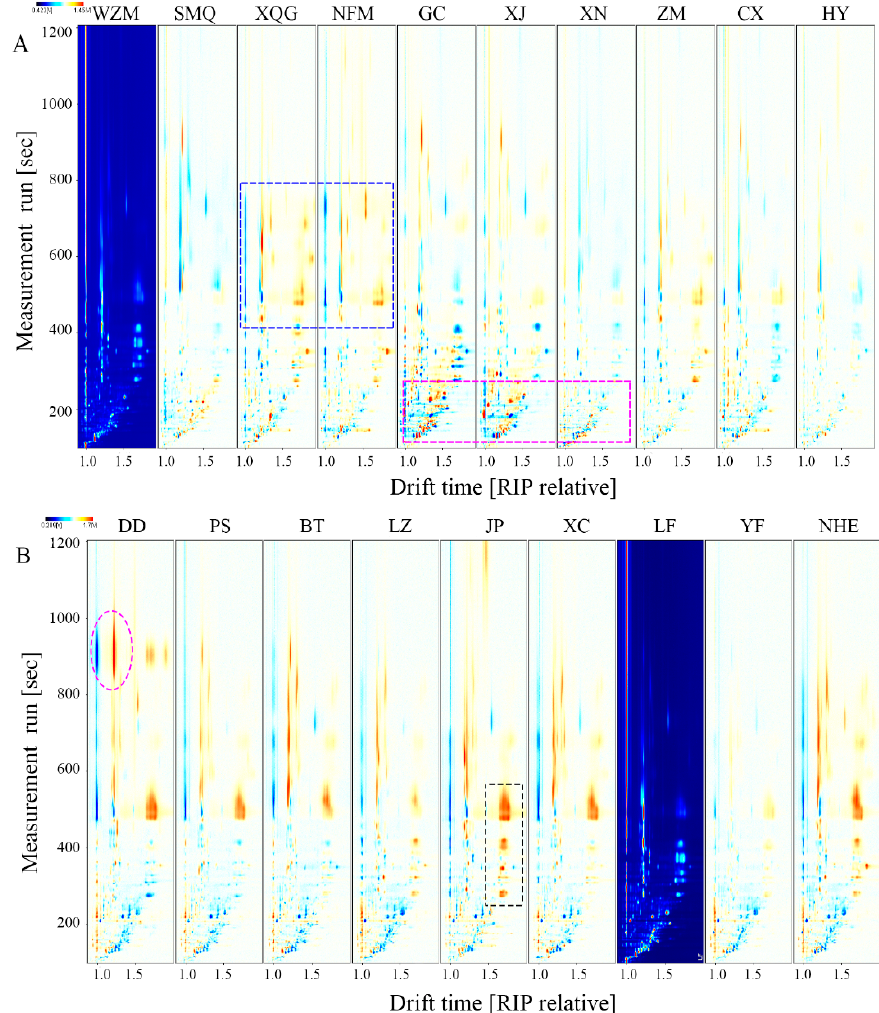
Figure 3. Two-dimensional topographic images of citrus tea: WZM, SMQ, XQG, NFM, GC, XJ, XN, ZM, CX and HY are shown in ( A ); DD, PS, BT, LZ, JP, XC, LF, YF and NHE are shown in ( B ).